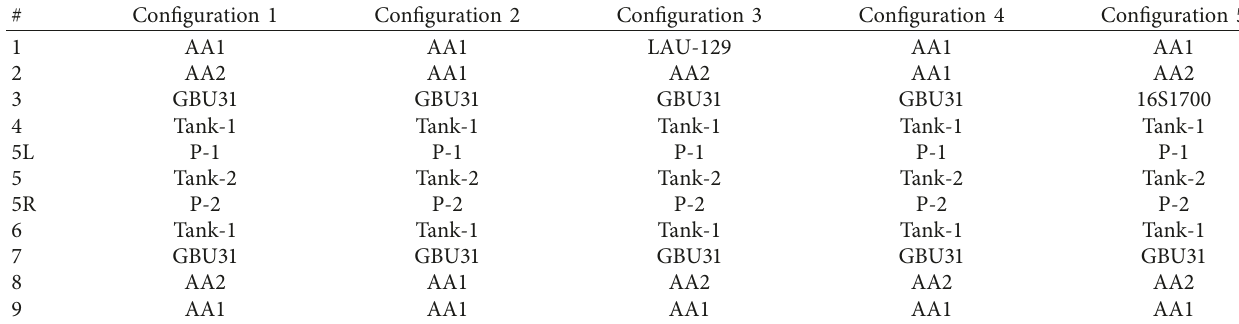
Table 7: Loading configurations.